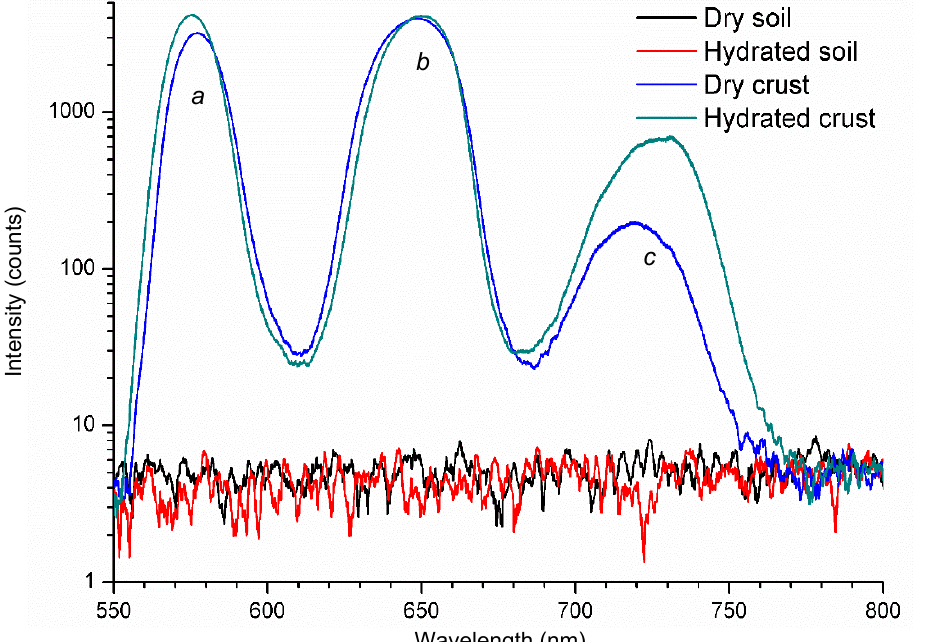
Figure 4. Laser-induced fluorescence spectra obtained from dry and hydrated soils and biological crusts. Each spectrum of the figure corresponds to a mean value obtained by averaging 128 returns from 7-ns laser pulses generated by a frequency-doubled Q-switched Nd:YAG laser [69] at the wavelength of 532 nm. To avoid any damage to the photosynthetic apparatus of the plants under investigation, the chosen laser-to-sample distance provided the spot diameter at the surface location of about 1 cm 2 , which, with the selected laser pulse energy of 5-mJ, corresponds to the fluence of 5 mJ/cm 2 , far below the damage threshold [18].